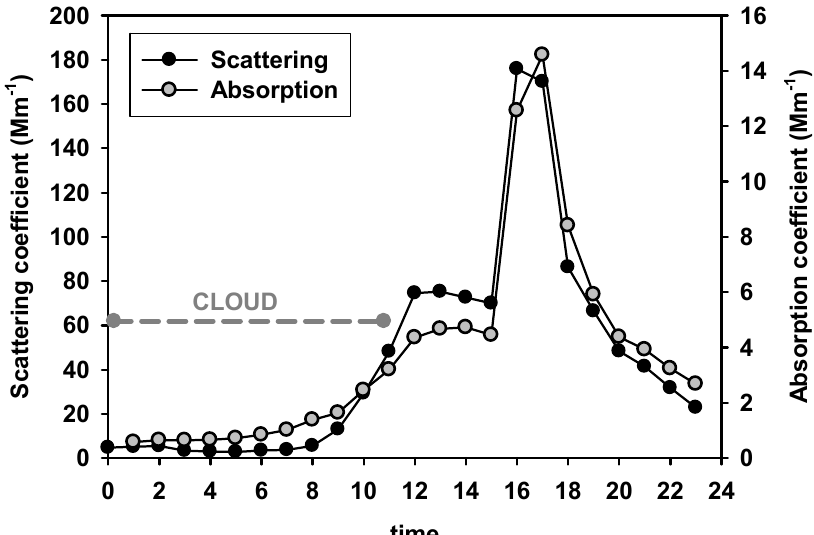
Figure 9. Scattering and absorption coefficients at a wavelength of 550 nm 30 July 2010. Grey horizontal bar indicates the time that the station was inside a cloud. Time is UTC +